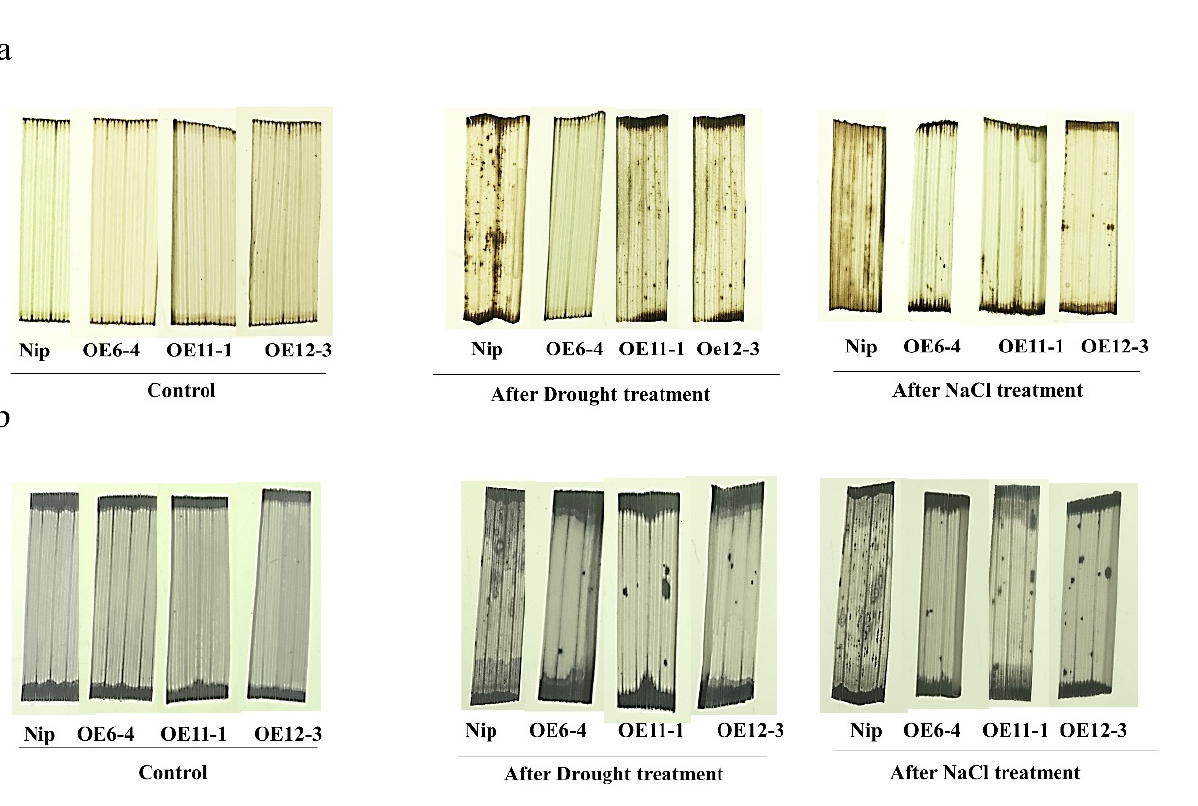
Figure 8. Accumulation of reactive oxygen species in OsMLP423 transgenic plants. ( a ) DAB staining was used to detect superoxide anion (O 2 − ) in the plants overexpressing OsMLP423 before and after drought and salt treatments. ( b ) Hydrogen peroxide accumulation in plants overexpressing OsMLP423 before and after drought and salt treatments was detected using NBT staining. In addition, the activities of SOD, POD, and CAT under salt and drought stresses were detected. The results showed that there was no significant difference in the activities of su- peroxide dismutase, peroxidase, or catalase between the overexpression lines and the wild type under the control conditions, whereas under the salt and drought stress conditions, the overexpression lines exhibited significantly greater enzymatic activity than the wild type (Figure 9a–c). We also found that the content of MDA in the overexpression lines was significantly lower than that in the wild type, indicating that the OsMLP423 overexpression lines had less cell membrane oxidative damage under stress conditions (Figure